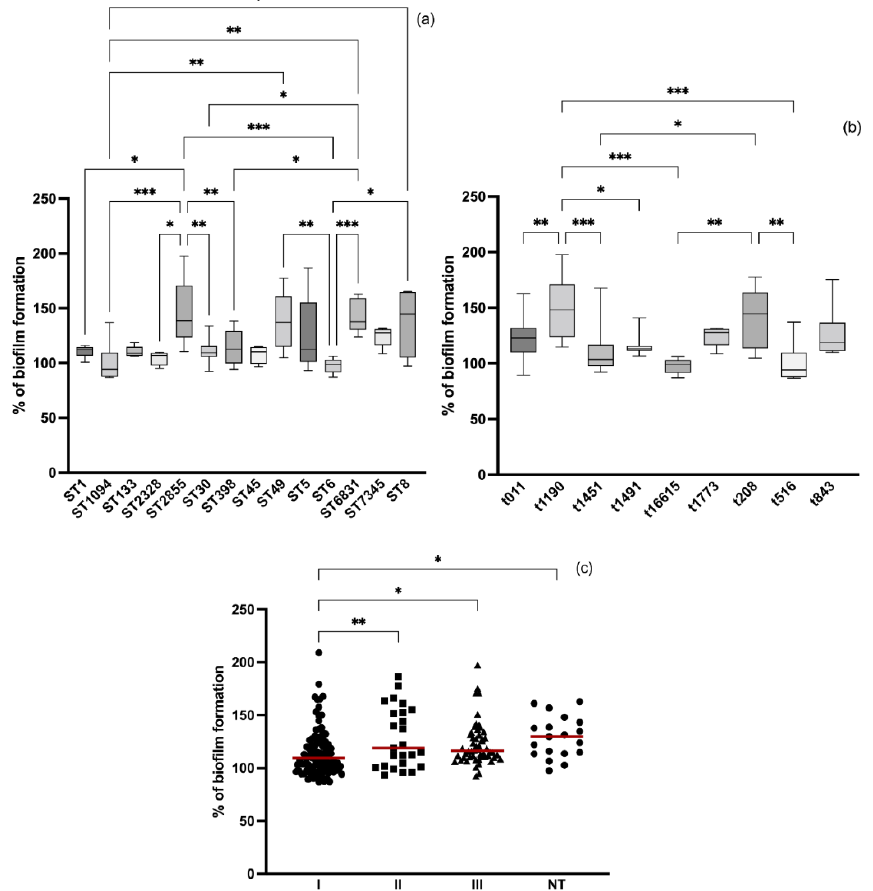
Figure 5. Biofilm formation among isolates grouped into different clonal lineages. Relationship between biofilm formation and: ( a ) STs; ( b ) spa -types and ( c ) agr types. The red lines represent the average of biofilm mass formed by all isolates. Statistical significance was determined using Tukey’s multiple comparison test (* p < 0.05; ** p < 0.01; *** p <